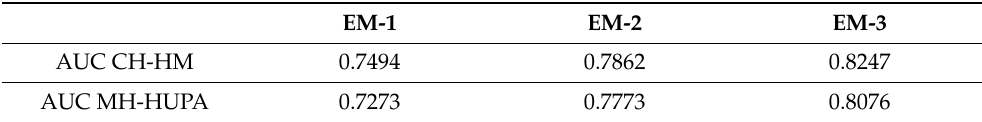
Table 5. Estimated parameters of the models in Grupo Hospitales de Madrid (CH-HM) and